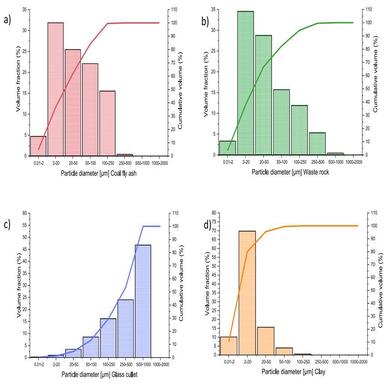
Particle size distribution of raw mineral materials used: a) FA; b) WR, c) GC; d) C.